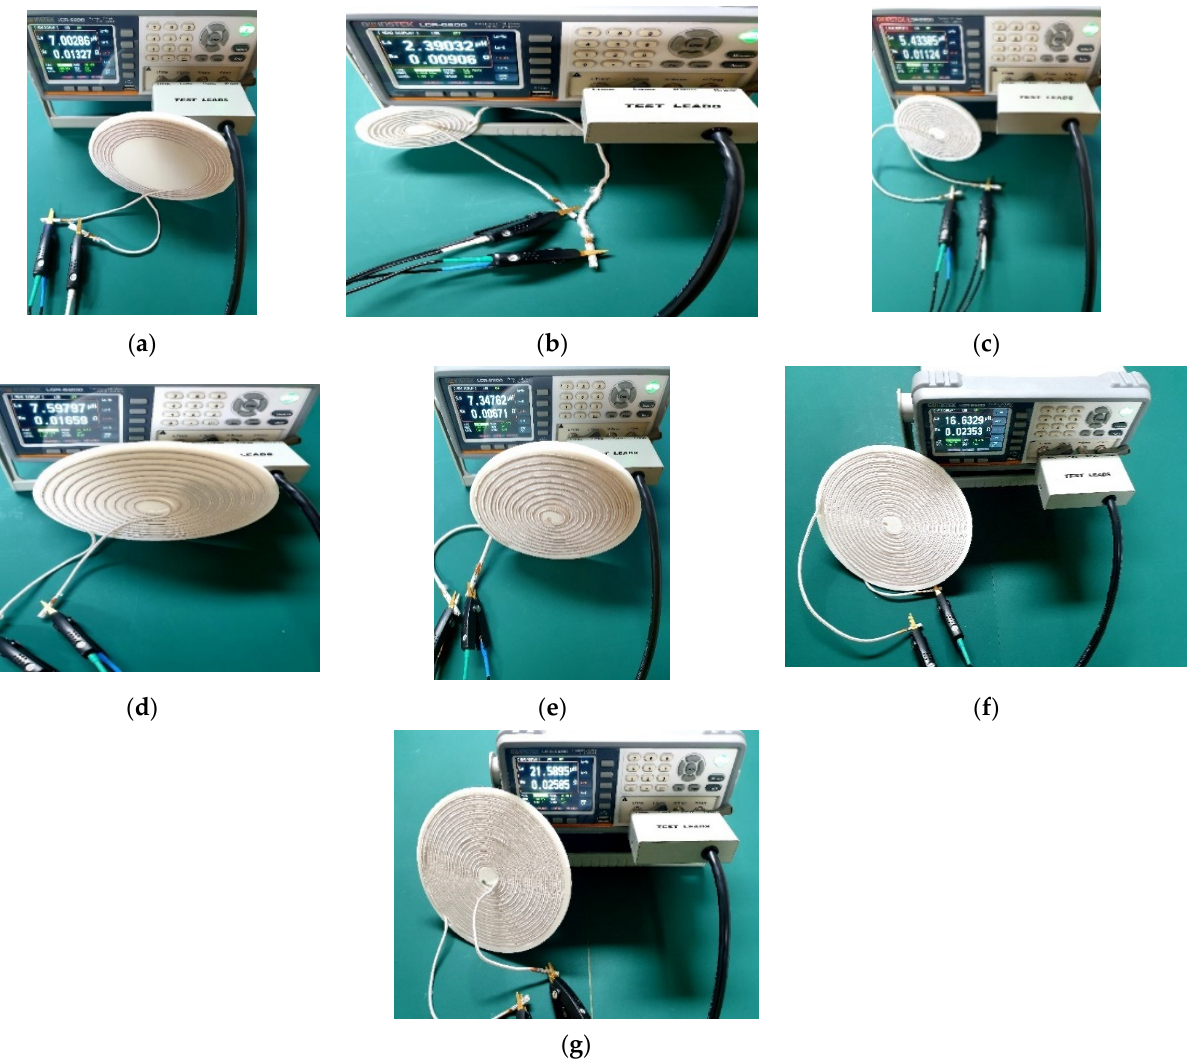
Figure 6. Self-inductance. ( a ) Six-turn coil having parameters R i = 85 mm, s + w = 5 mm, w = 3.6 mm. ( b ) Seven-turn coil, s + w = 5 mm, R i = 13 mm, w = 3.6 mm. ( c ) Ten-turn coil, s + w = 5 mm, R i = 10 mm, w = 3.6 mm. ( d ) Ten-turn coil, s + w = 7.5 mm, R i = 10 mm, w = 3.6 mm. ( e ) Ten-turn coil, s + w = 7.5 mm, R i = 10 mm, w = 4.2 mm. ( f ) Fifteen-turn coil, s + w = 5 mm, R i = 10 mm, w = 3.6 mm. ( g ) Seventeen-turn coil s + w = 4.41 mm, R i = 10 mm, w = 3.6 mm. Table 7. Comparison between the proposed and measured self-inductances. Number of